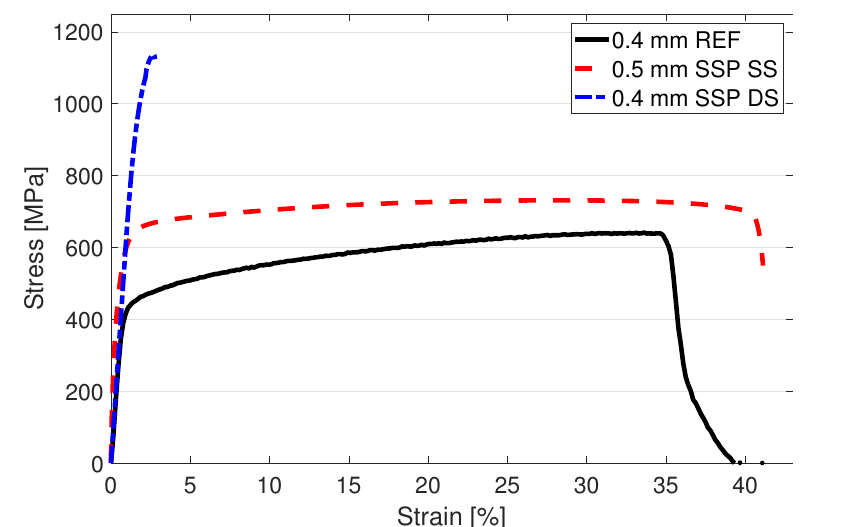
Figure 11. Tensile strength of a thin 316L sheet metal and after subjecting to SSP treatment for single side (SS) and both sides